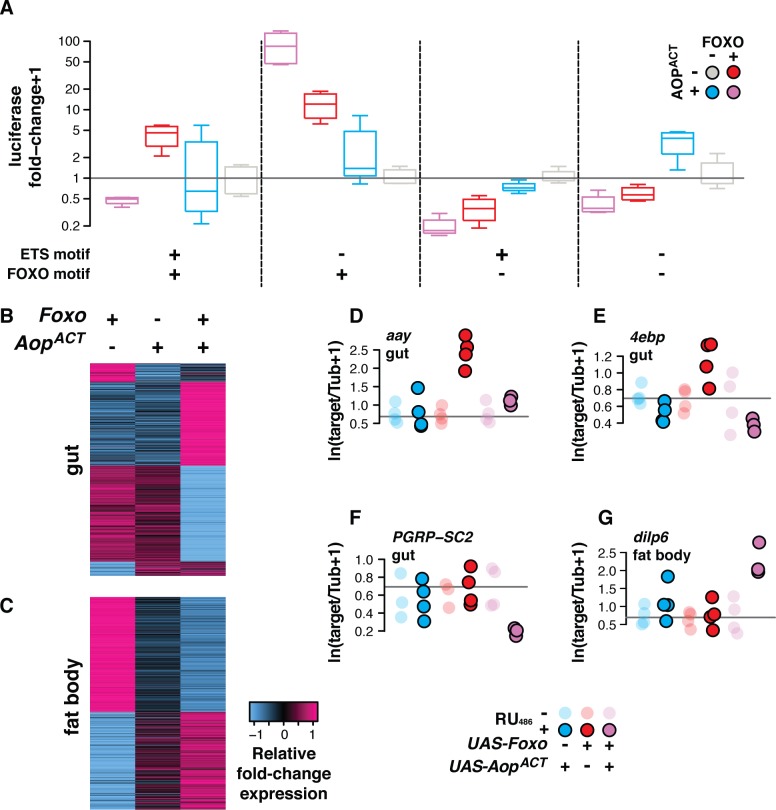
Aop modulates Foxo’s transcriptional outputs.(A)
In vitro (Drosophila S2 cells), AOPACT alters FOXO's transcriptional output. Representative of three replicate experiments shown, see S2 Fig for each separate replicate and their pool. When both AOPACT and FOXO can bind a promoter (ETS and FOXO motifs present), AOPACT directly moderates FOXO activity. When only FOXO can bind a promoter (only FOXO motif present), AOPACT indirectly synergises with FOXO activity. No significant reporter activity is detected in the absence of FOXO motifs. Statistical modelling confirms that consequence of combining TFs depends on combination of promoter motifs (linear model: Foxo:Aop:FRE:EBM F1,48 = 11.41, p = 1e-3). Plot shows luciferase reporter activity from Drosophila S2 cells transfected with expression constructs containing combined ETS-binding motifs (EBMs—GGAA) and FOXO-responsive elements (FREs—AACA), upstream of a basal Adh-Fireflyluciferase reporter. Activity is shown following normalisation to internal Renillaluciferase controls, and calculation of fold-change over the median expression of each reporter in the absence of FOXO and AOPACT. (B-C)
In vivo, expressing AopACT moderates and synergises with Foxo to determine transcriptomic output in the gut and fat body (S106). Sets of differentially expressed genes regulated interactively by Aop and Foxo (10% FDR) are shown. Rows represent relative fold-change in expression (Z-scores, log2 fold-change expression from DESeq2 output). (D-G) qRT-PCR validation of patterns indicated in vivo by transcriptomics. In gut, (D—E)
AopACT abrogates Foxo's activation of aay and 4ebp (linear models: aay genotype:RU486 F2,17 = 15.43, p = 1e-4; 4ebp genotype:RU486 F2,17 = 8.38, p = 2e-3), while (F) they synergise to repress PGRP-SC2 in the gut (linear model: genotype:RU486 F2,15 = 4.06, p = 0.03); (G)
AopACT and Foxo synergise to activate dilp6 in fat body (linear model: genotype:RU486 F2,17 = 6.61, p = 8e-3).